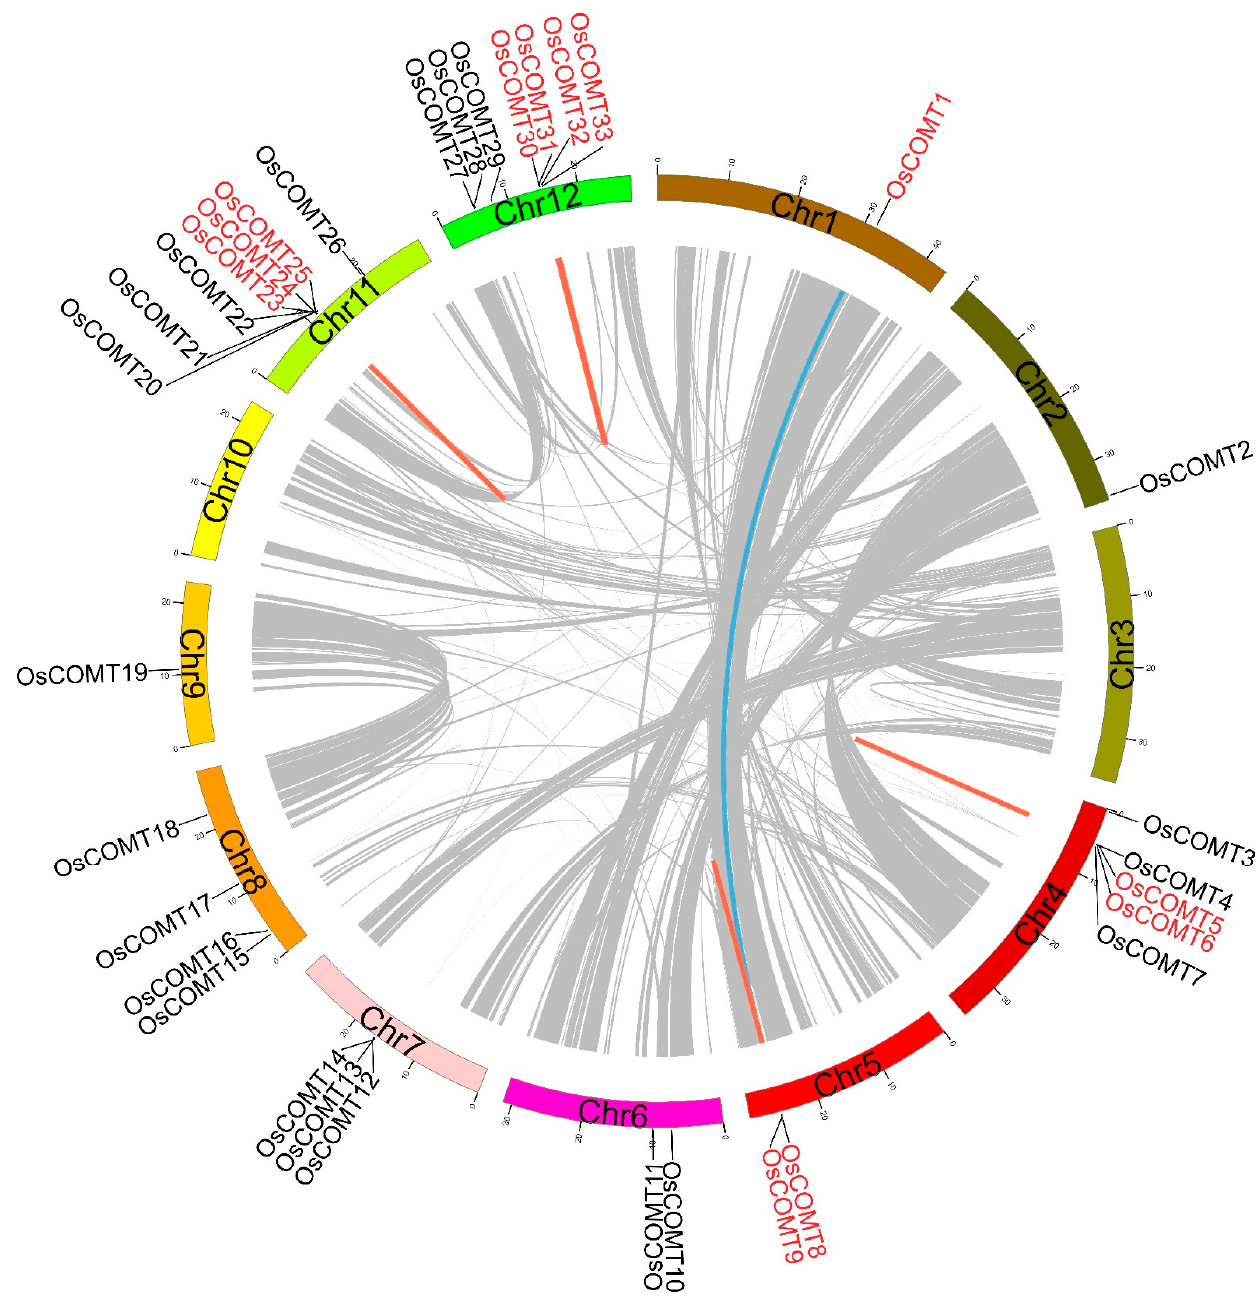
Figure 1. The gene duplication types and chromosomal distribution of OsCOMTs . The WGD gene pair is linked with a thick blue line. TD gene pairs are linked with thick orange lines. The duplica- tions genes were marked in red. The scale marked on the chromosome indicates the chromosome length (Mb).